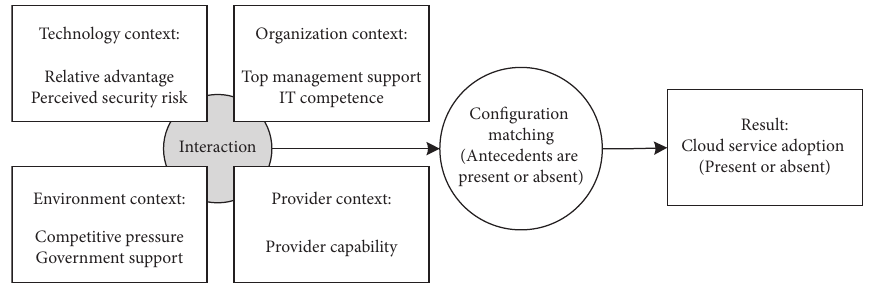
Figure 1: Research